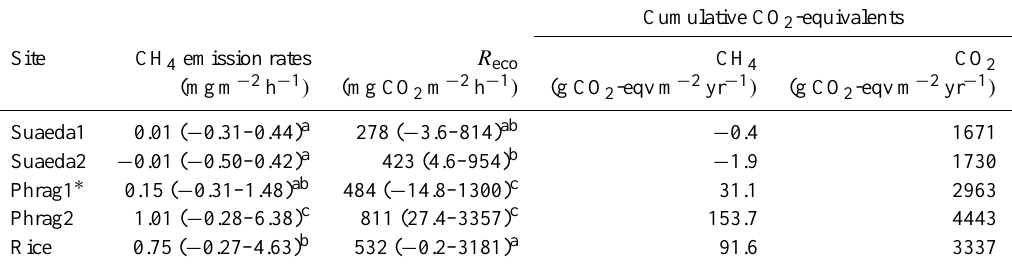
Table 4. Mean CH 4 emission and ecosystem respiration rates ( R eco ) with ranges in parentheses, and cumulative CO 2 equivalents from CH 4 and CO 2 emissions, respectively, from two Phragmites australis wetlands and one rice paddy during April-November 2012 in the Liaohe Delta, Northeast China. CH 4 fluxes are converted to CO 2 -equivalents using a factor of 25. Superscript letters represent significant differences ( p <0.05) among